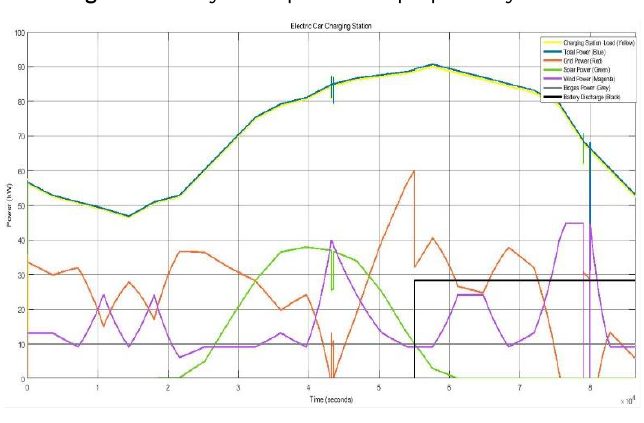
Fig. 10. Battery backup added in proposed system